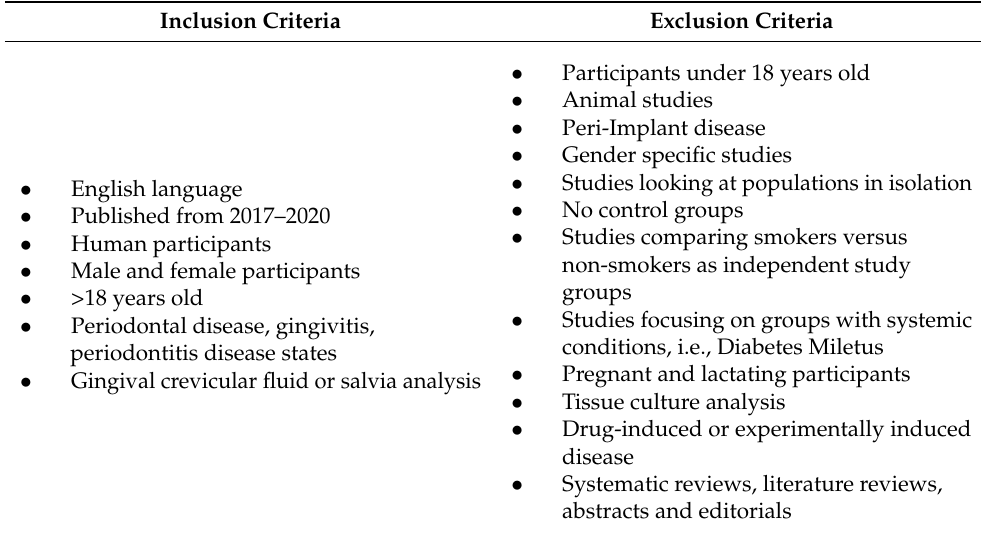
Table 1. Inclusion and exclusion criteria for articles reviewed from database